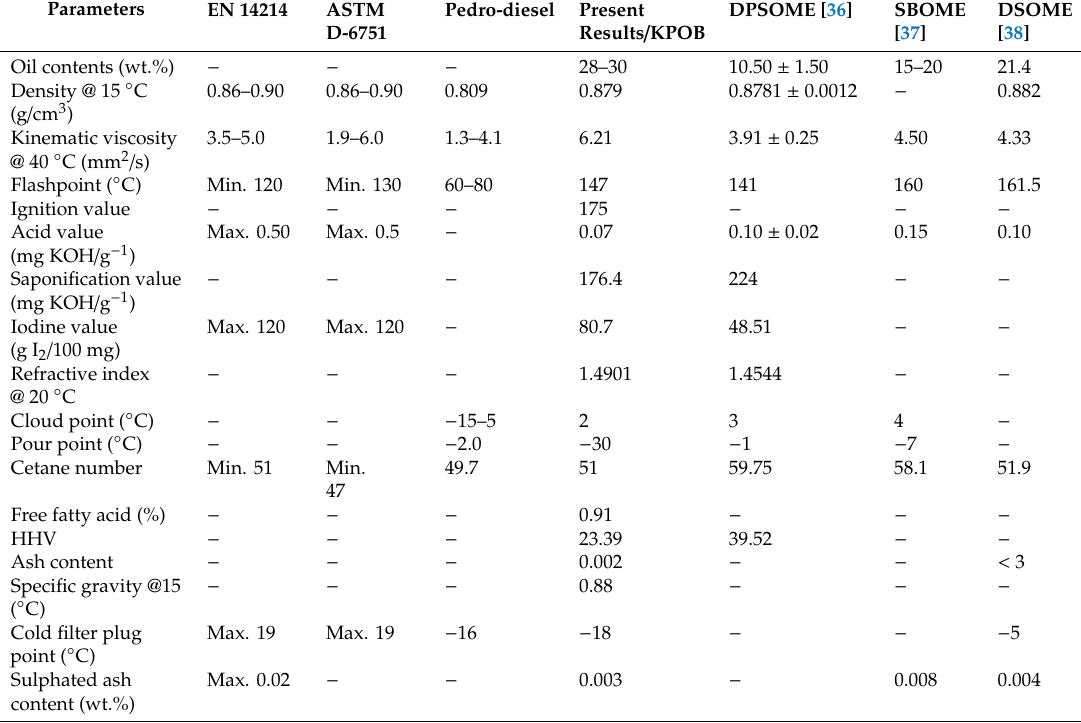
Table 2. Physiochemical characterizations of KP seed oil biodiesel (KPSOB) in comparison with standards and plant fatty acid methyl esters